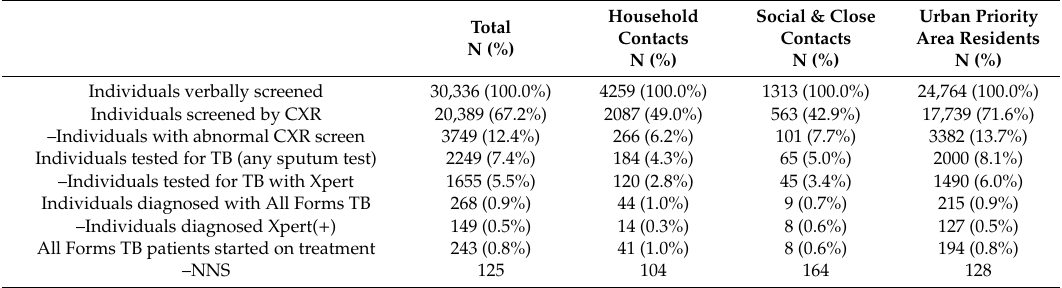
Table 2. TB treatment outcomes by urban priority group. Hai Phong and Quang Nam, Viet